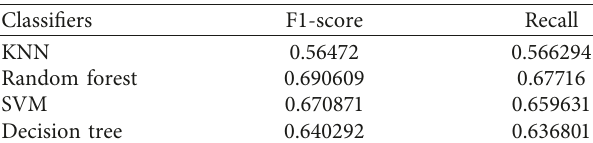
Figure 5: Precision with different classifiers. Table 1: The F1-score and recall on different machine learning models used in the study.